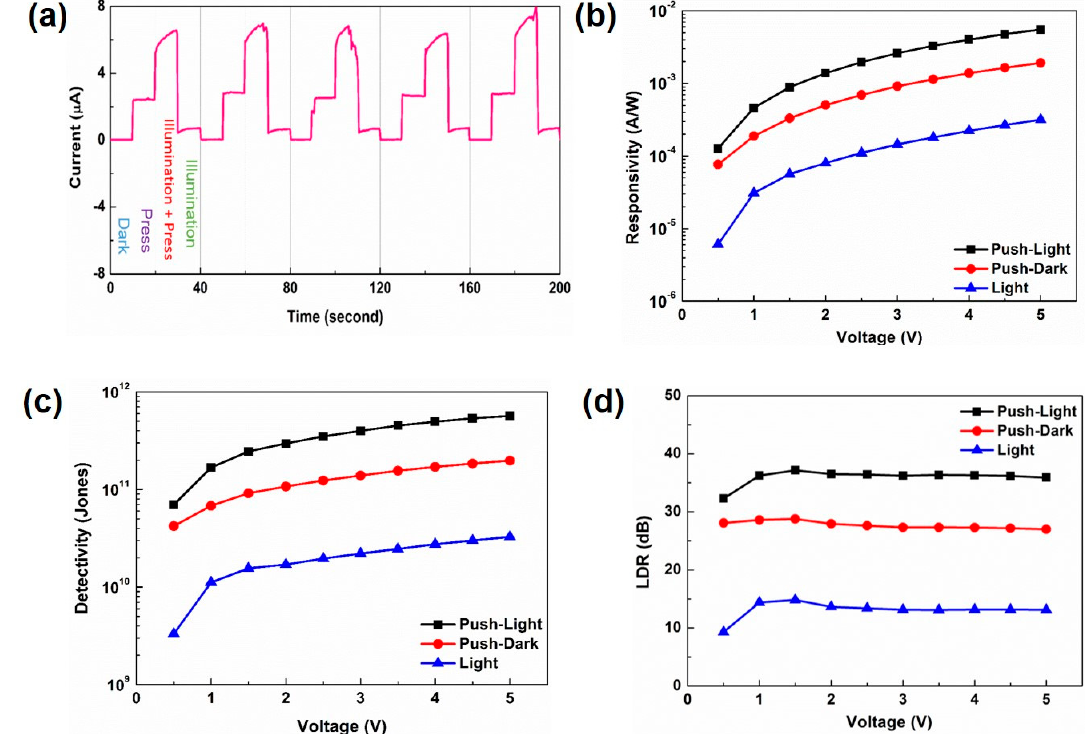
Figure 9. ( a ) Repeatable switching response of the device under 200 cycles with stress and illuminations. ( b ) Responsivity as a function of voltage under normal and stress condition. ( c ) Detectivity as a function of voltage under normal and stress condition. ( d ) Linear dynamic range LDR as a function of voltage under normal and stress